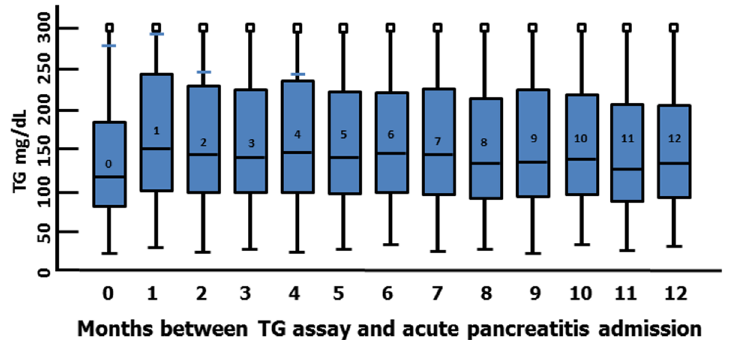
Fig 1. Mean triglyceride level by months until admission for acute pancreatitis among 20,608 veterans (FY2006-FY2009).